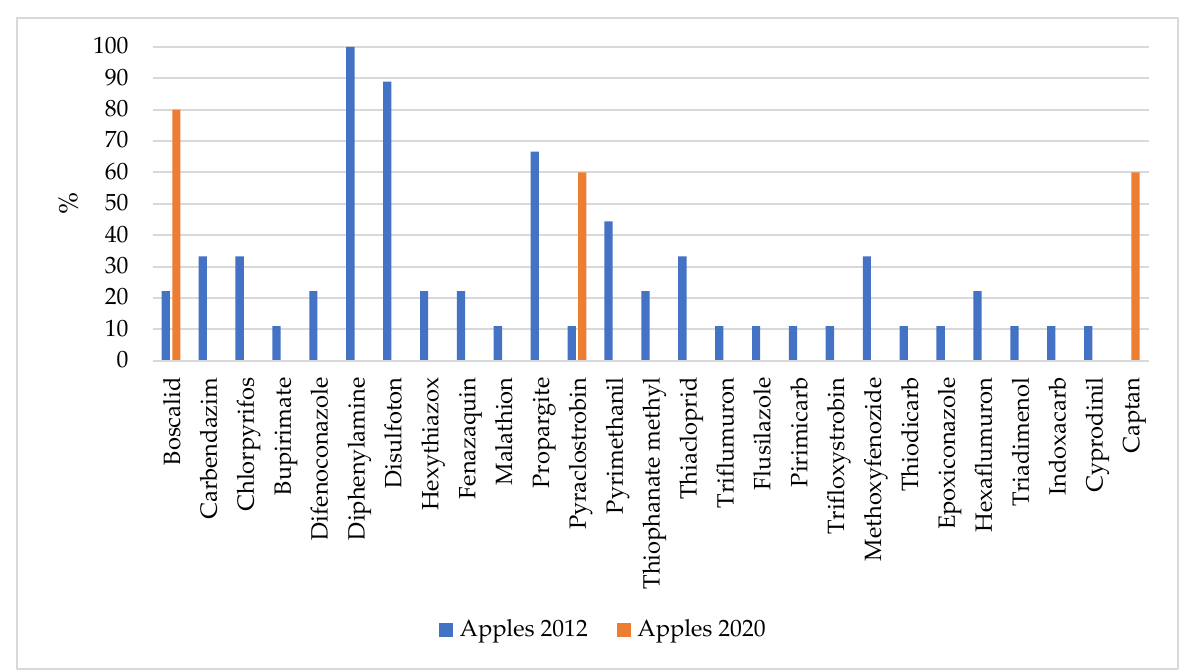
Figure 3. Frequency of occurrence of pesticides in the analysed samples of whole apples in 2012 and 2020, expressed as percentage share.